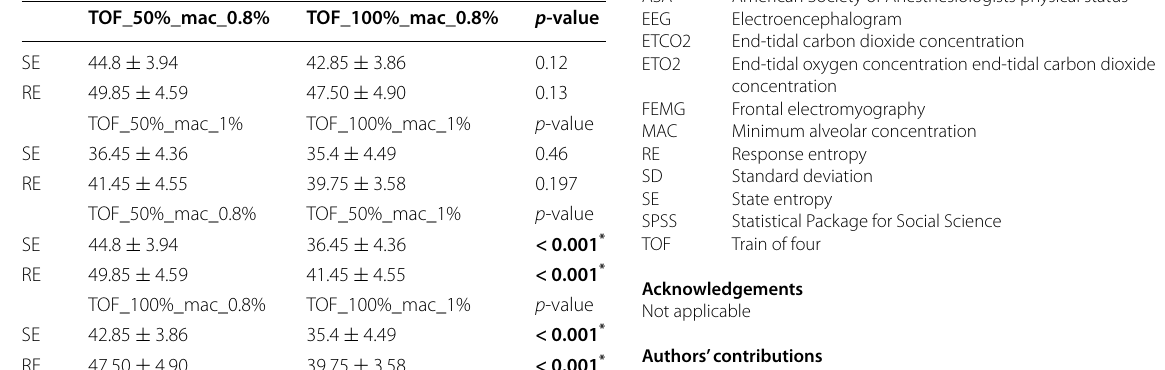
Table 4 SE and RE at different MAC and TOF of rocuronium group